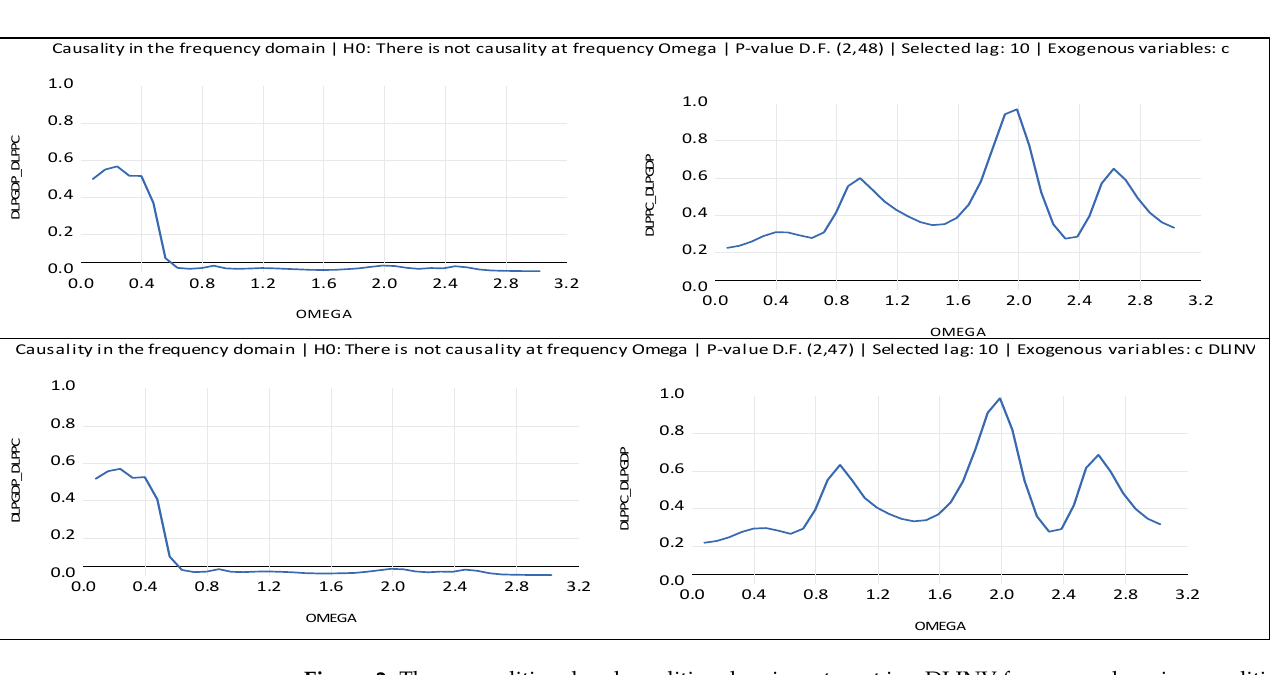
Figure 1: Electricity Consumption in Major Consuming Sectors